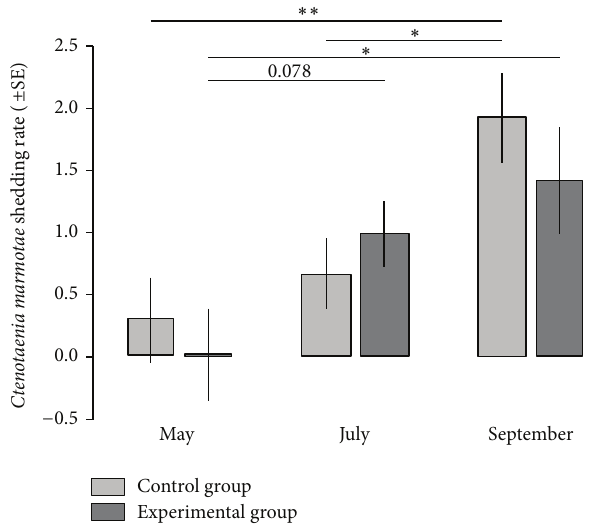
Figure 1: Effect of anthelmintic treatment on the faecal shedding rate of Ctenotaenia marmotae proglottids in the Alpine marmot, M. marmota latirostris . The C. marmotae shedding rate represents proglottid numbers on the scale from 0 to 3 per gram of a faecal sample, as more precise proglottid/egg quantification was not possibleduetothephysicaldamageofmostproglottids.Thesymbols above lines ∗∗ , ∗ , and 0.078 refer to 𝑃 < 0.001 , 𝑃 < 0.05 , and 𝑃 = 0.078 , respectively. The 𝑃 values reported are adjusted for multiple comparisons using the Bonferroni single-step